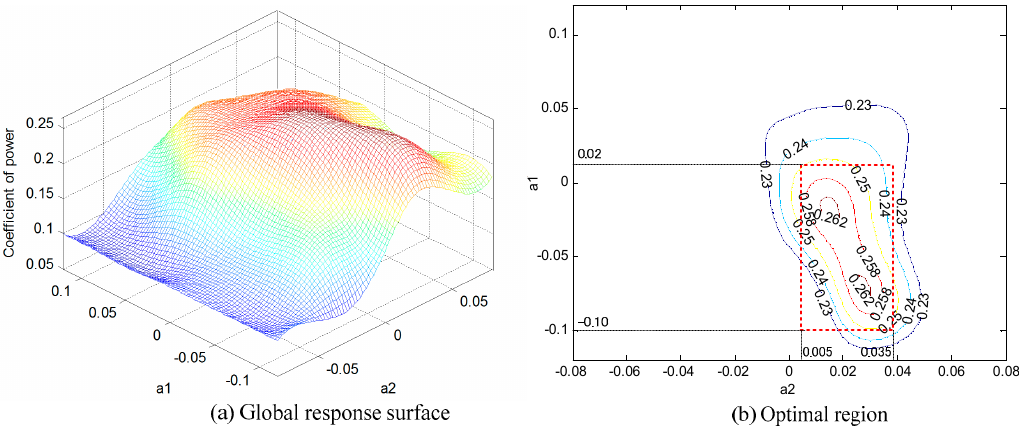
Figure 12. Global response surface and optimal region.